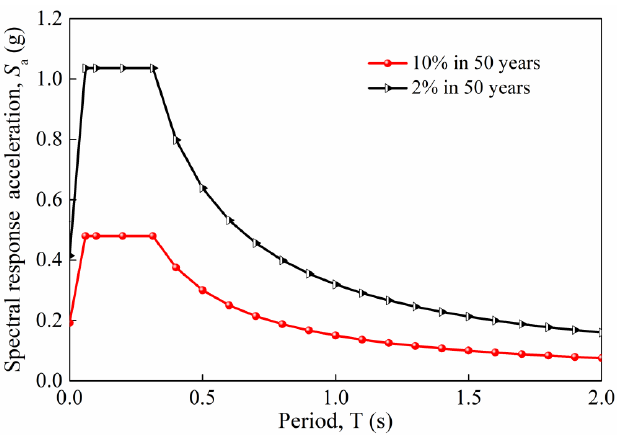
Figure 13. Acceleration response spectrum for two seismic exceedance possibilities.